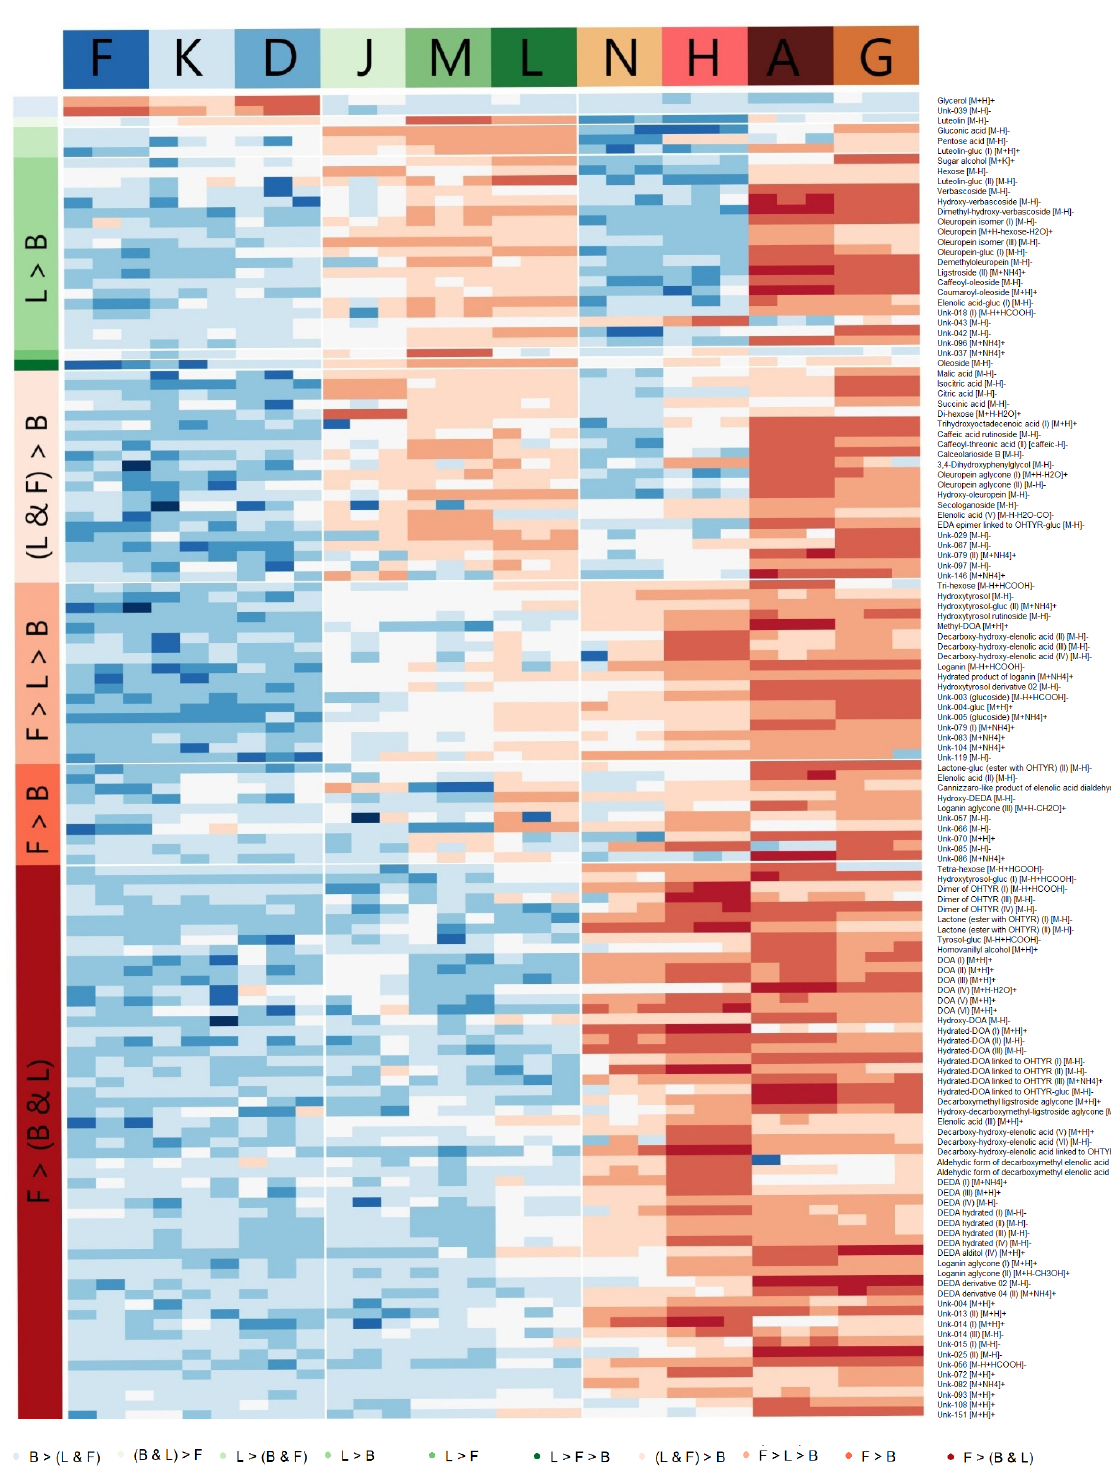
Figure 2. The heat map of discriminant features according to the part of the plant used was selected employing the most intensive feature of each compound. Blue and orange cells correspond to low- and high-metabolite levels, respectively. Columns are samples (codified as indicated in Table 4), and rows are compounds colored by behavior distribution among products’ classes. Product classes refer to buds-based products (B), leave-based products (L) and fruit-based products (F). The symbology of rows’ groups (e.g., “F > L > B”) indicates the behavior of the compound distribution among the products’ classes according to the Kruskal–Wallis test.